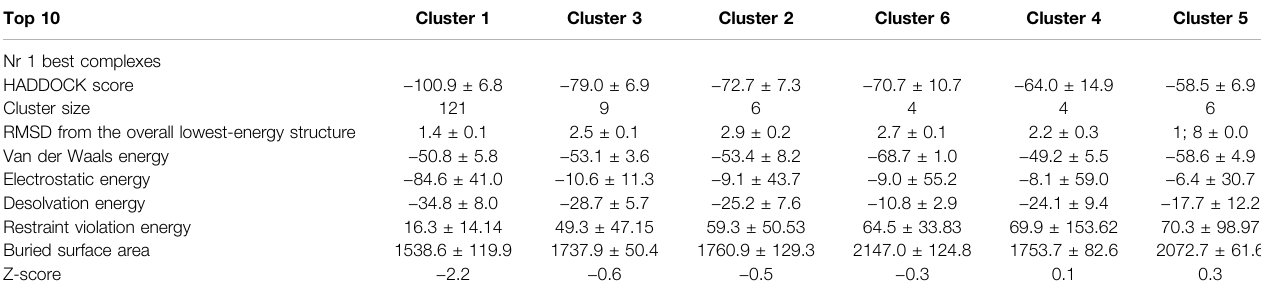
TABLE 1 | Molecular docking (Na V 1.5 – AahII) HADDOCK grouped 150 structures into 5 clusters, representing 94.0% of the water-re fi ned HADDOCK models. The statistics of the top 5 clusters are presented in this table. The top cluster is the most reliable according to the HADDOCK score. The Z-score indicates the number of standard deviations from the mean of this cluster in terms of score (the most negative HADDOCK score is the best).